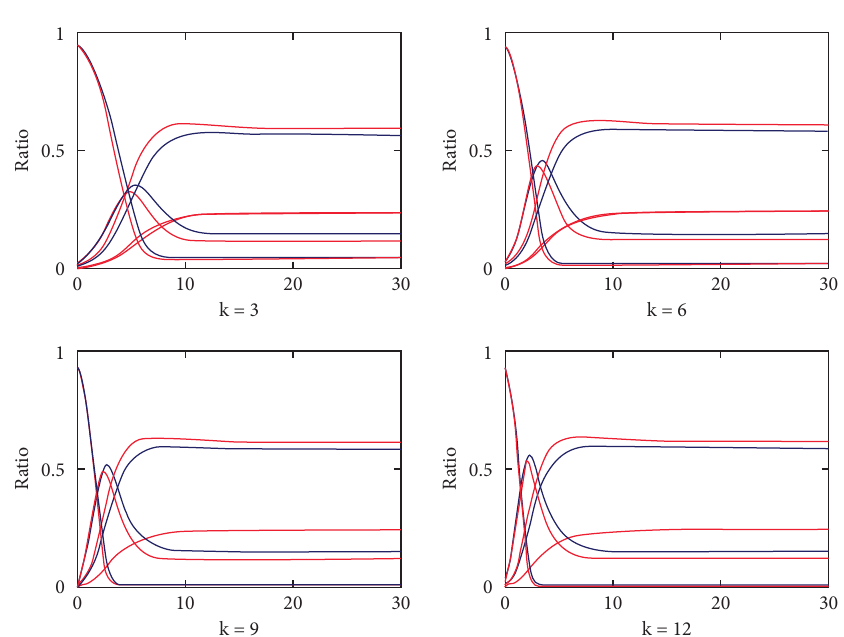
Figure 8: Information dissemination before and after stigmatization in small world network with different k values.